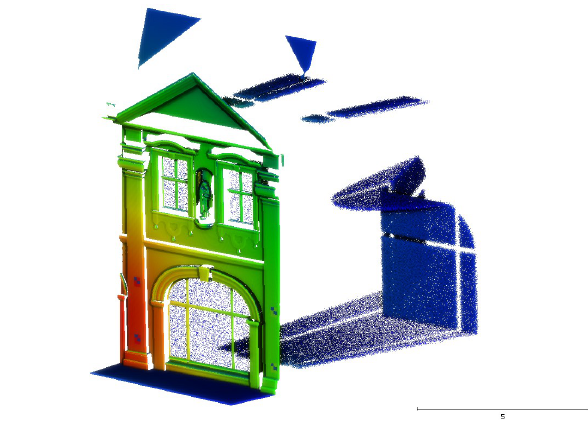
Figure 10. Glass material behaviour in